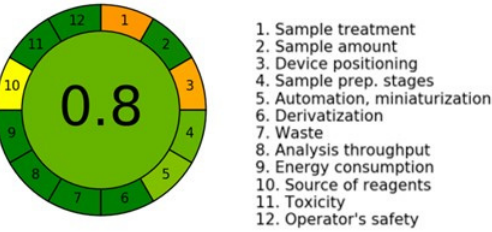
Figure 9. Results of AGREE analysis for UHPLC-DAD-QqQ-MS/MS method.